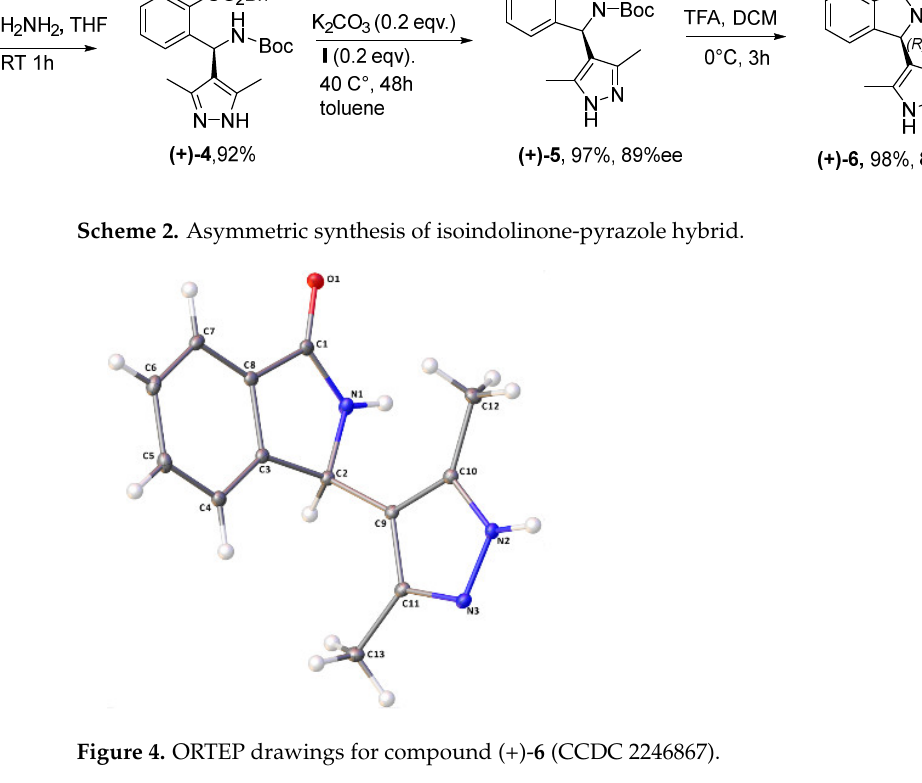
Figure 4. ORTEP drawings for compound (+)- 6 (CCDC 2246867).